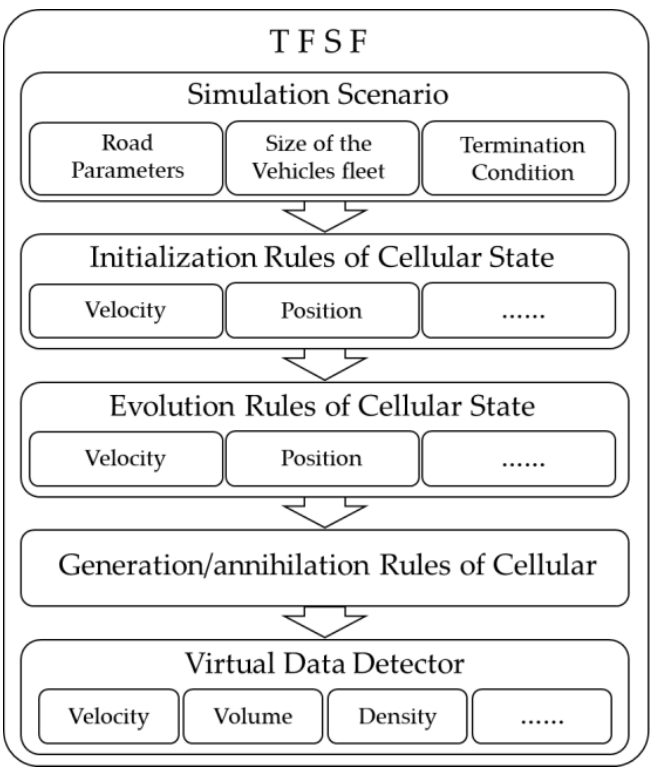
Figure 3. The basic structure of the traffic flow simulation framework (TFSF).